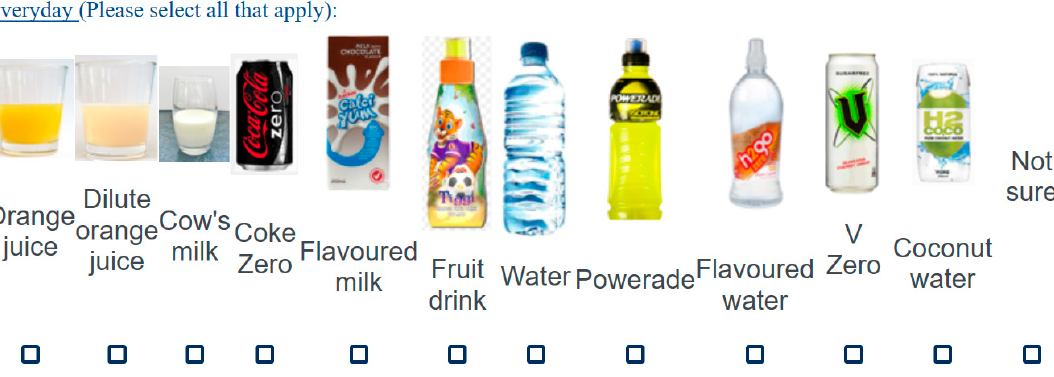
Figure 1. Example item from the food-choices section of the knowledge questionnaire.